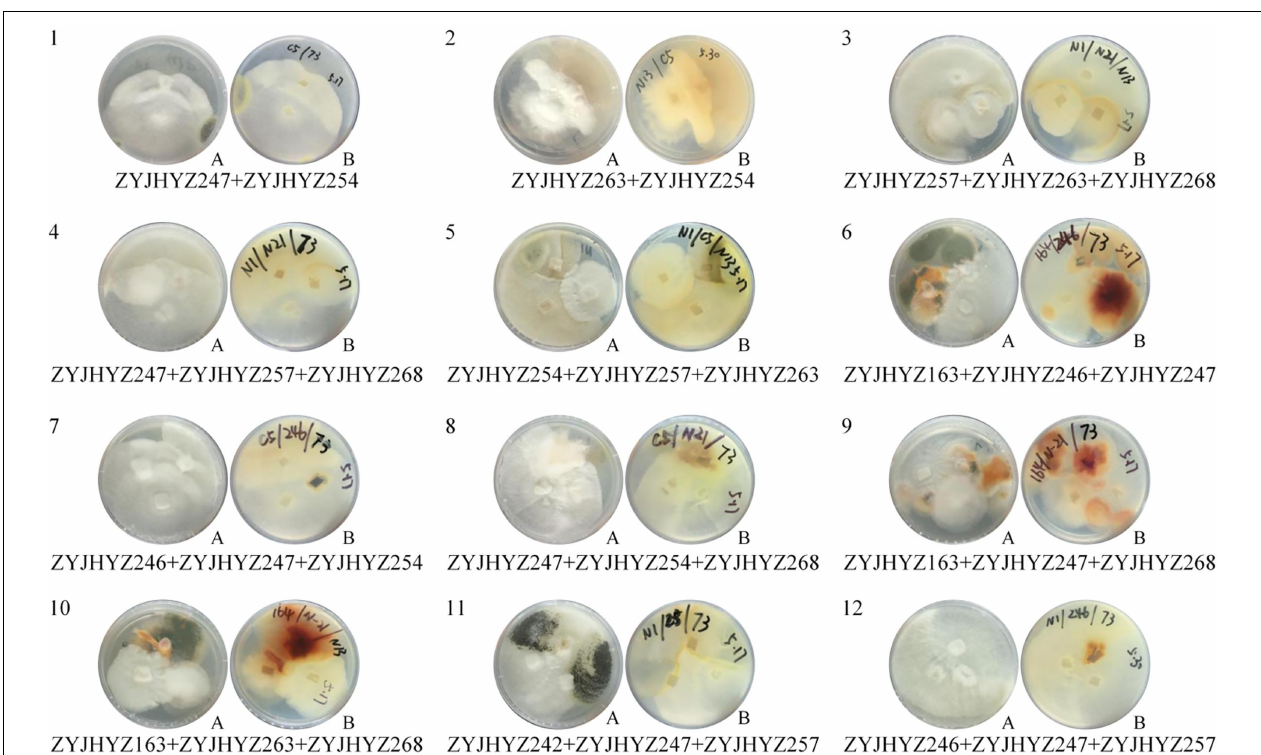
FIGURE 4 | Growth of fungi in synergistic combinations (co-cultivation). 1, 2, 3, 4 ... is co-cultivation code; (A) . from above, (B) . from